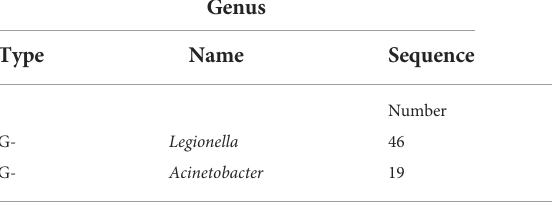
TABLE 1 Results of mNGS in the BALF of the patient.